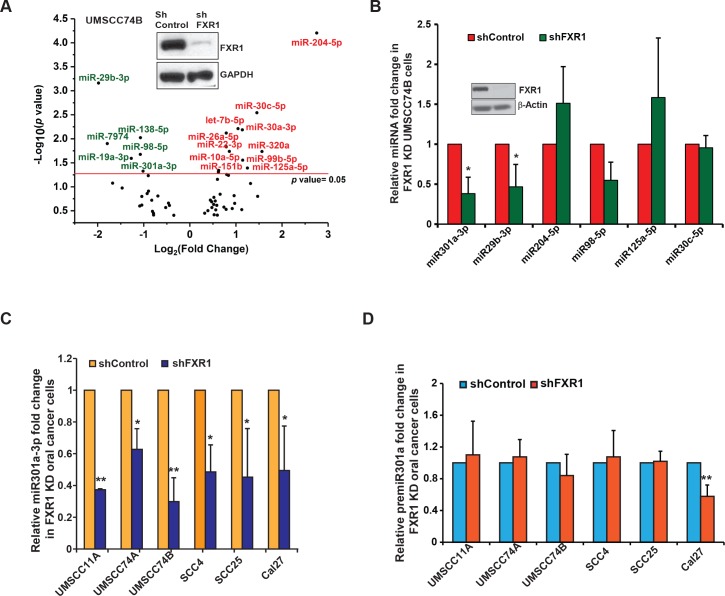
FXR1 modulates the expression of a subset of miRNAs in oral cancer cells.(A) Volcano plot of differential miRNA expression in UMSCC74B cells in the absence of FXR1. Red: up-regulated and green: down-regulated miRNAs in the absence of FXR1. The inset shows the knockdown efficiency of FXR1 by shRNA (TRCN0000159153) compared to a scrambled shRNA where GAPDH serves as a loading control. X-axis signifies the log2 values of the miRNA fold change where y-axis plots the -log10-p-values of the differentially expressed miRNAs in the FXR1 knockdown cells compared to control. (B) qRT-PCR of the altered miRNAs in FXR1 knockdown UMSCC74B cells. RNU6 serves as an endogenous control. Inset shows the knockdown efficiency of FXR1 by shRNA (TRCN0000159153) compared to a scrambled shRNA where β-Actin serves as a loading control. (C) qRT-PCR is showing that miR301a-3p is significantly down-regulated in all the FXR1 knockdown HNSCC cell lines. RNU6 serves as an endogenous control. (D) qRT-PCR is showing that premiR301a is not altered in most of the FXR1 knockdown HNSCC cell lines except Cal27. 18S rRNA serves as an endogenous control. Data from B-D represent the mean of n  = 3 experiments. Statistical significance (p-value): *<0.05; **<0.005. See also S1 Fig.